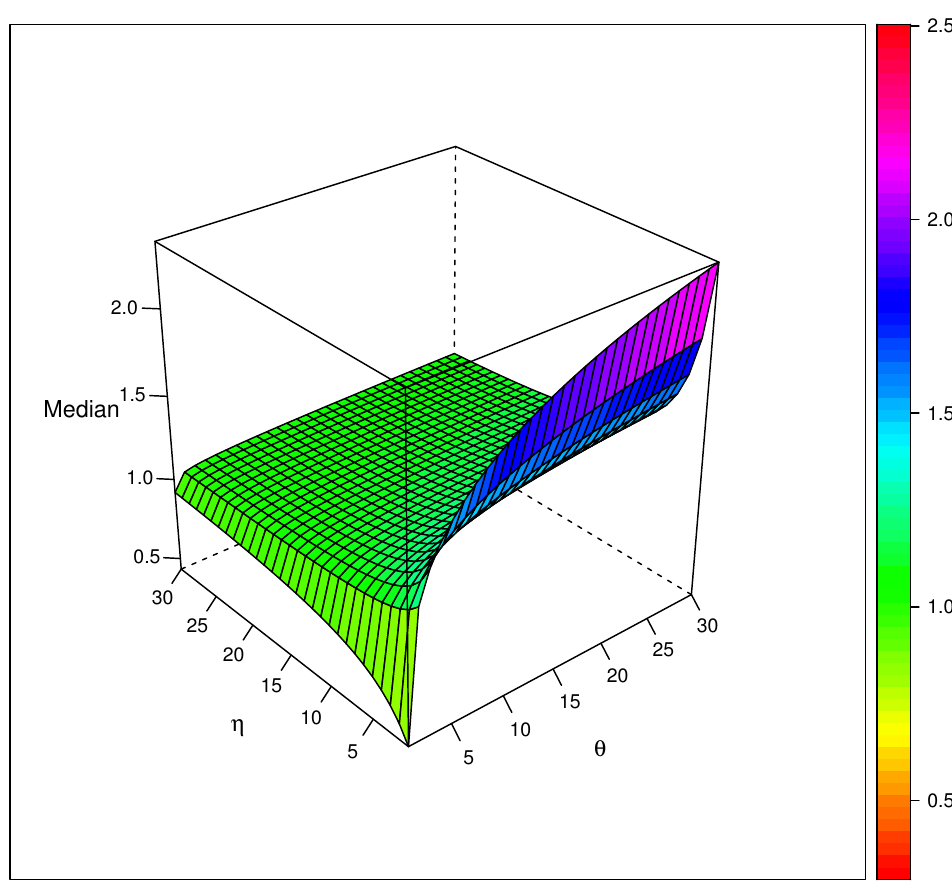
Figure 4. Median plot of EEP distribution with different